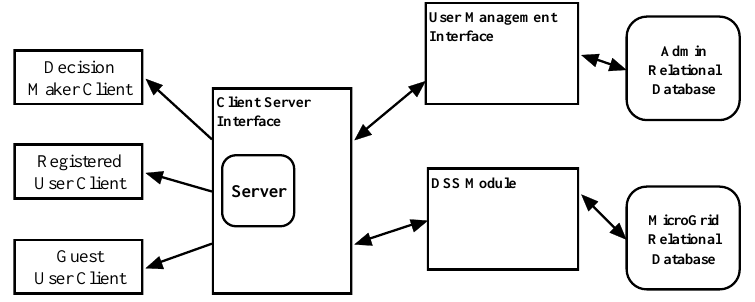
Figure 1. Smart DSS architecture for a microgrid, adapted from [22].